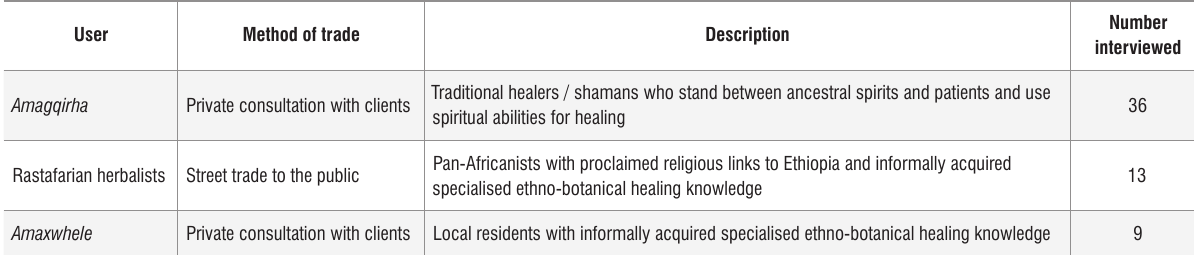
Typologies of traditional healers interviewed to determine motivations for wild harvesting and trading in natural